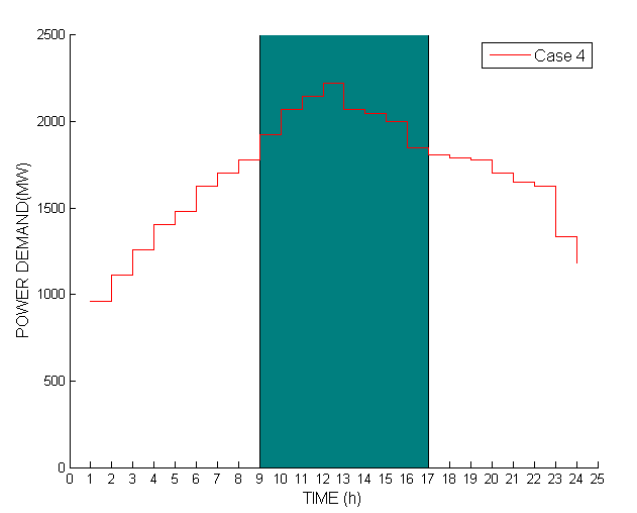
Figure 4. Initial power demand for Case